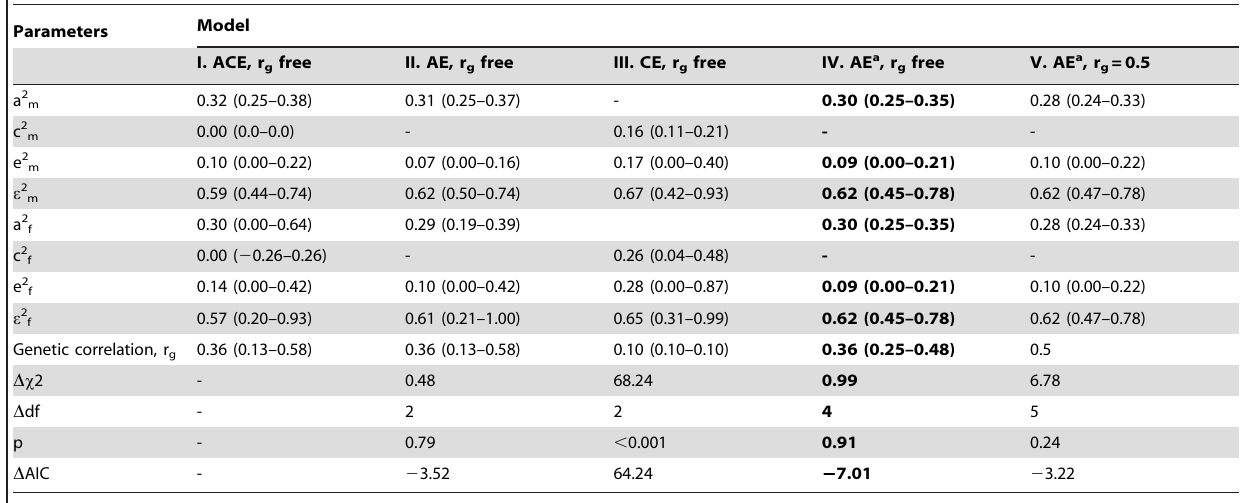
Table 6. Model-comparison results and variance component estimates (95% CI) for liability to disability pension (DP) (all diagnoses) among men and